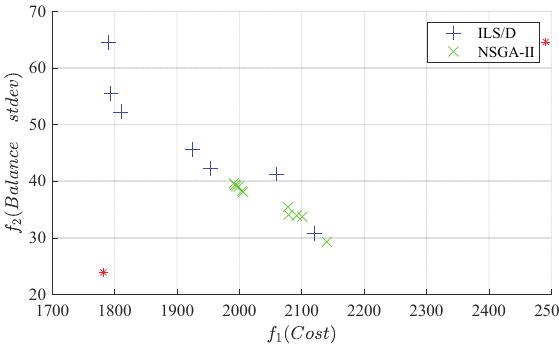
Fig. 6. The highest values of HV for fronts obtained by the ILS/D and NSGA-II